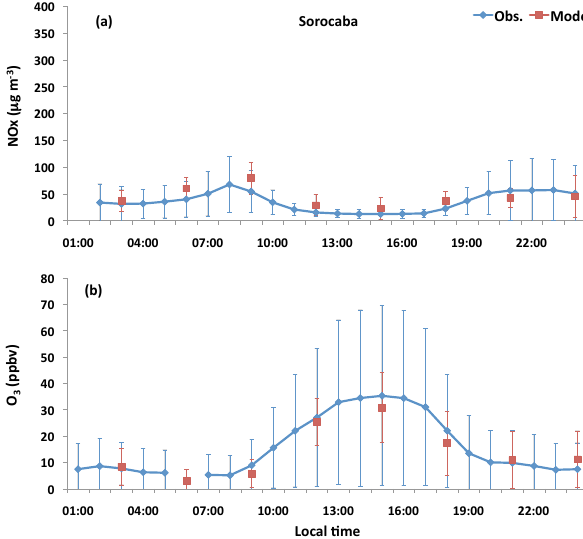
Fig. 12. Monthly (a) NO x mixing ratio (ppbv) and (b) ozone (ppbv) from a CETESB ground station (Parque Dom Pedro II) in S˜ao Paulo city and from the model.